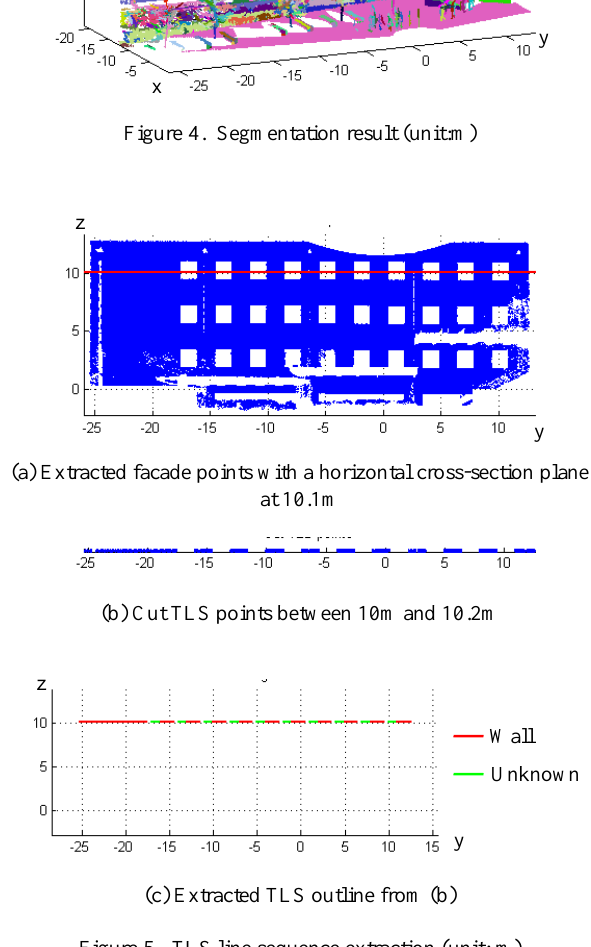
Figure 5. TLS line sequence extraction (unit: m)